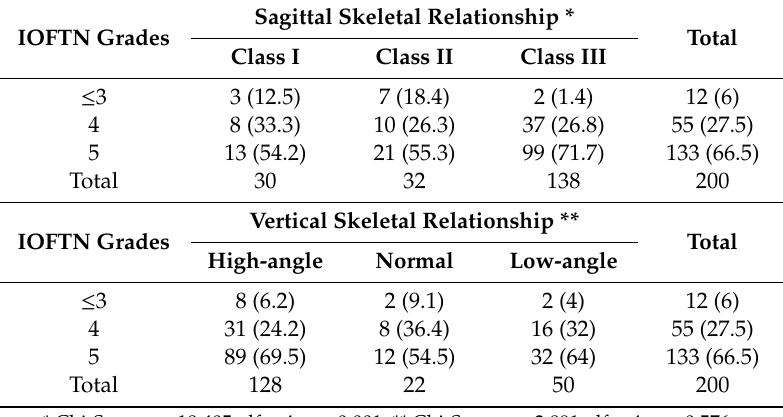
Table 5. Distribution of IOFTN grades according to sagittal and vertical skeletal